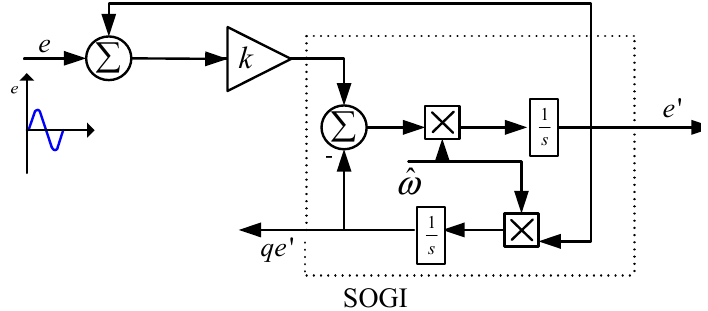
Figure 6. Orthogonal signal generator (OSG)–second-order generalized integrator (SOGI) standard structure.